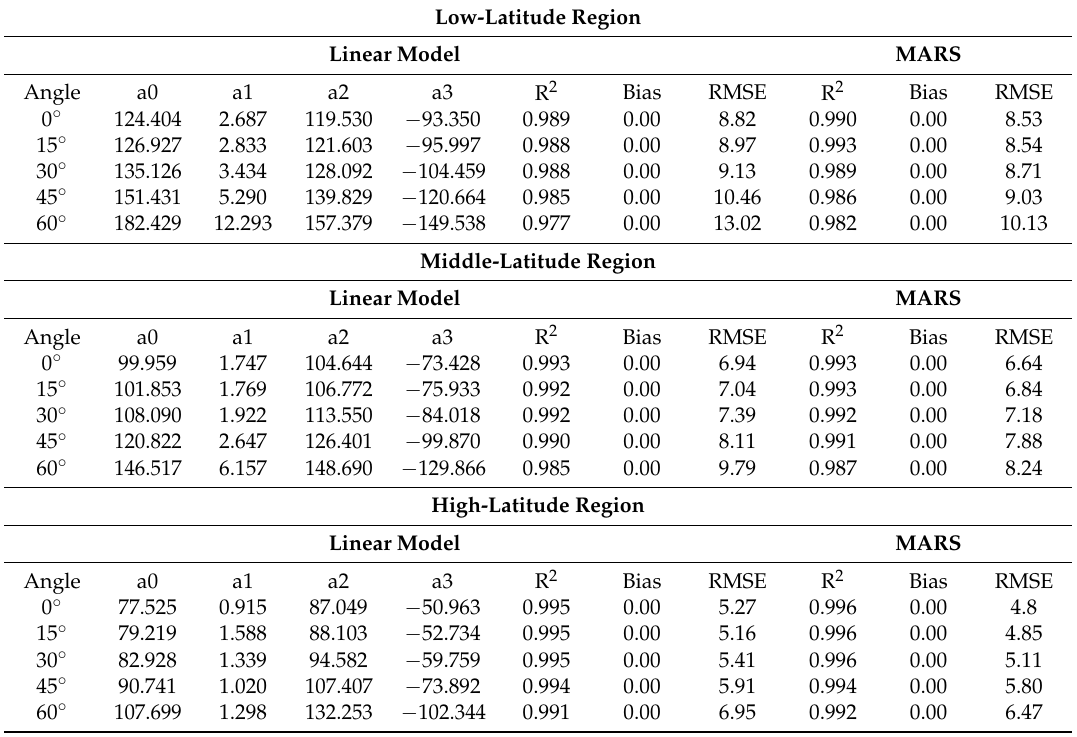
Table 2. Fitting results for the linear models and the Multivariate Adaptive Regression Spline (MARS)